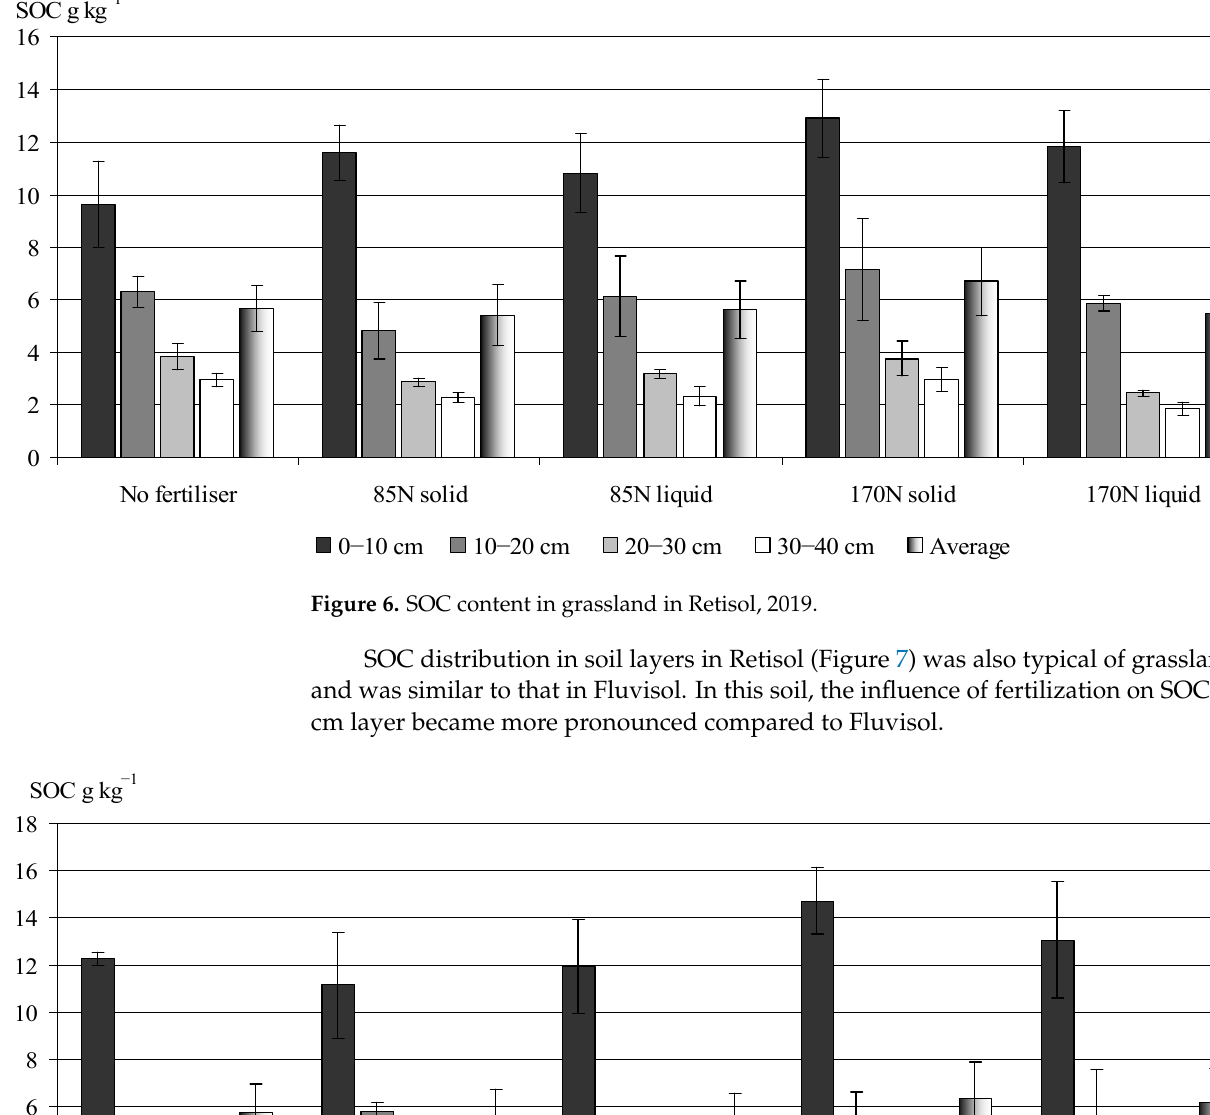
Figure 5. SOC content in grassland soil in Fluvisol, 2020 .